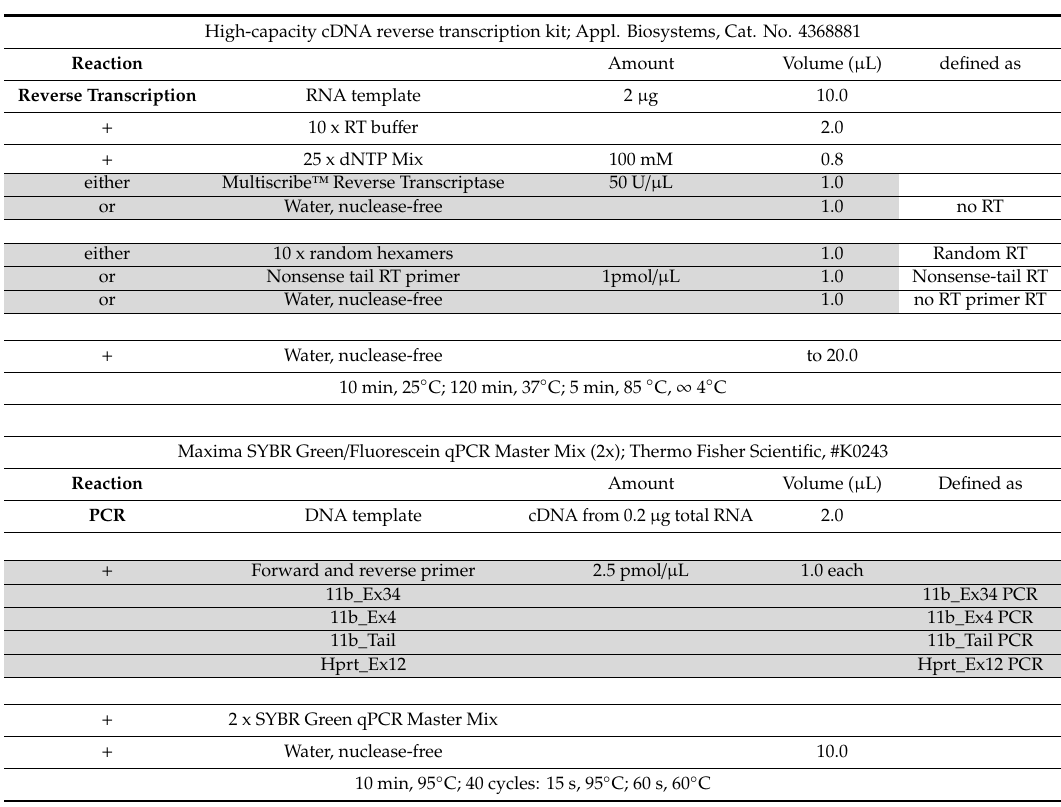
Table 2. Detailed protocol of the reverse transcription and PCR reactions performed in this study. Variable steps are highlighted in